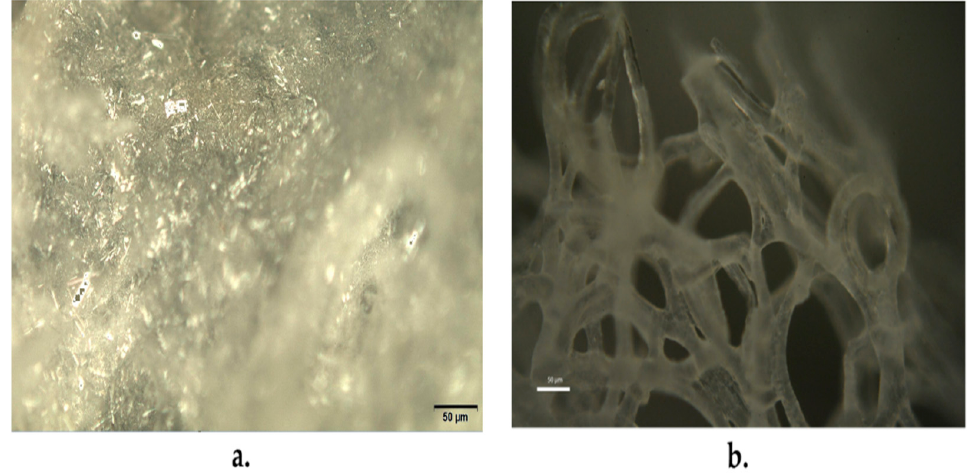
Figure 5. Optical micrographs of the residues of the keratin extraction process: ( a ) from chicken feathers; ( b ) from sheep wool. The scale bar indicates a 50 µm length.